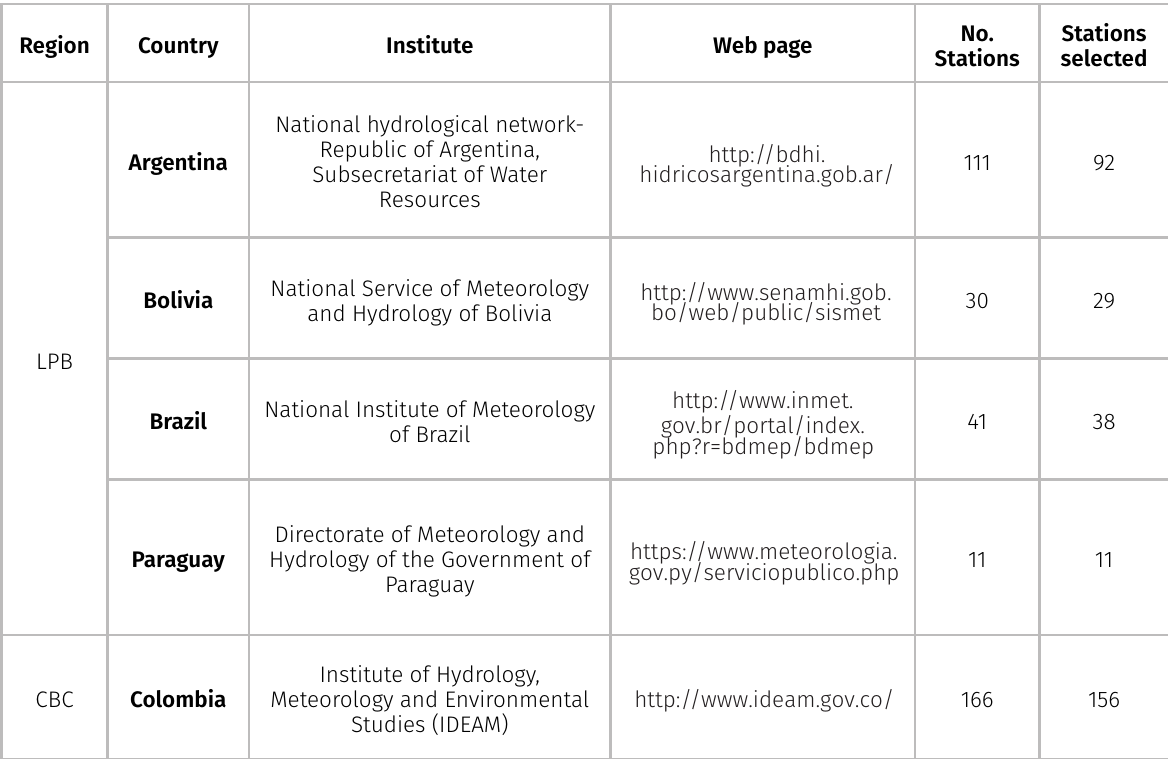
Table I. Information provided by the Meteorological Institutes in the study regions. Region Web page